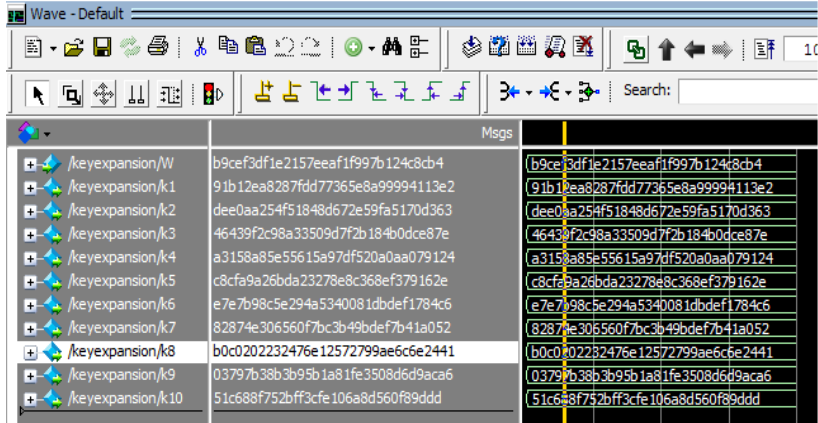
Figure 5. Simulation waveform of generated keys of AES-FJMKE designed in Virtex 4.